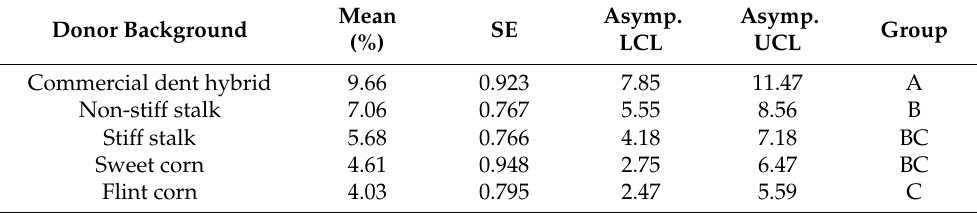
Table 4. Pairwise comparisons of the mean HIR in donor backgrounds.